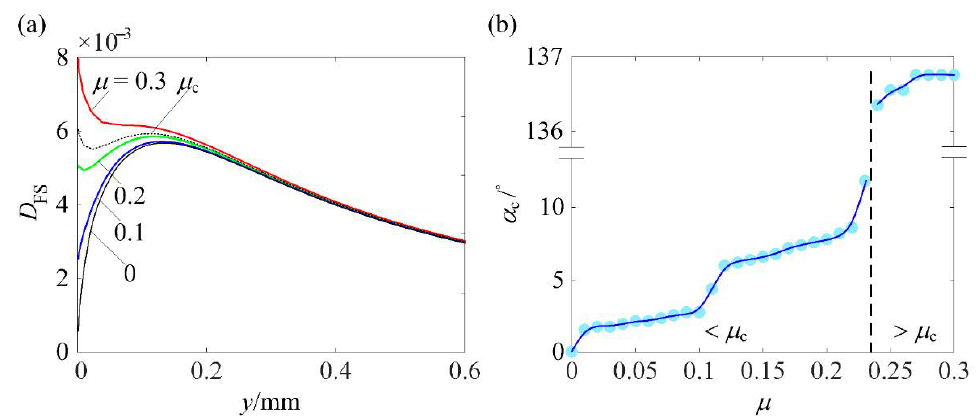
Figure 8. ( a ) D FS distribution along the depth for P / P rated = 1, μ = 0.1, 0.2, and 0.3, and ( b ) α c as a function of μ